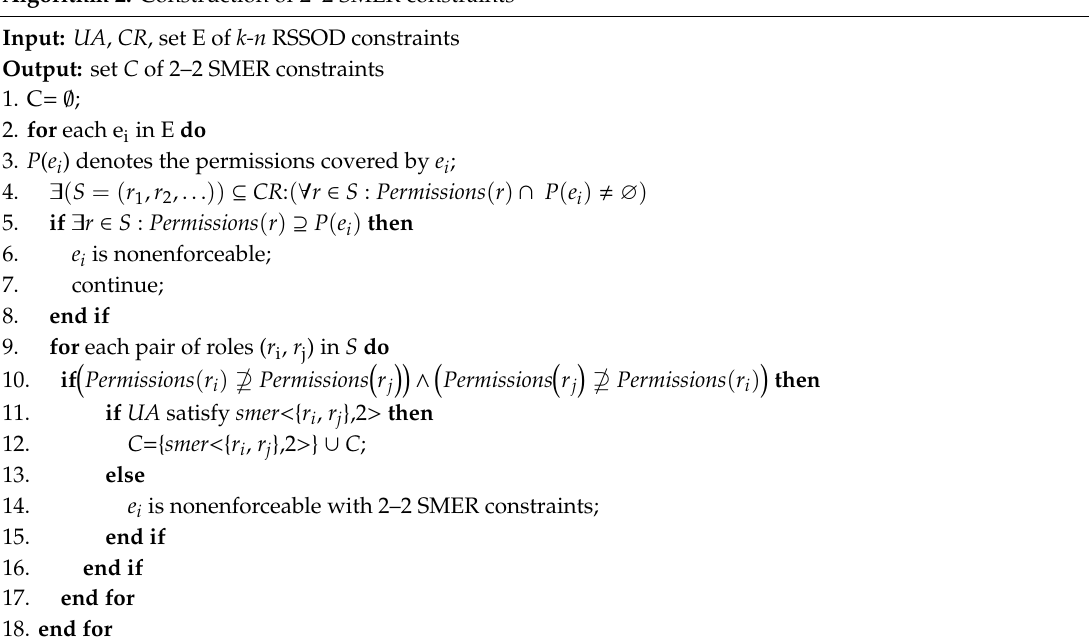
Algorithm 2. Construction of 2–2 SMER